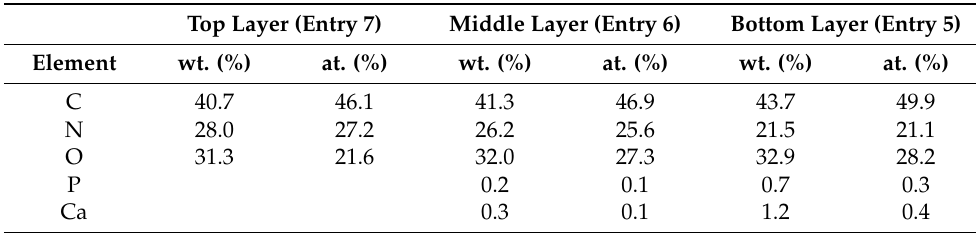
Table 2. EDX data for the trilayered construct TL1.